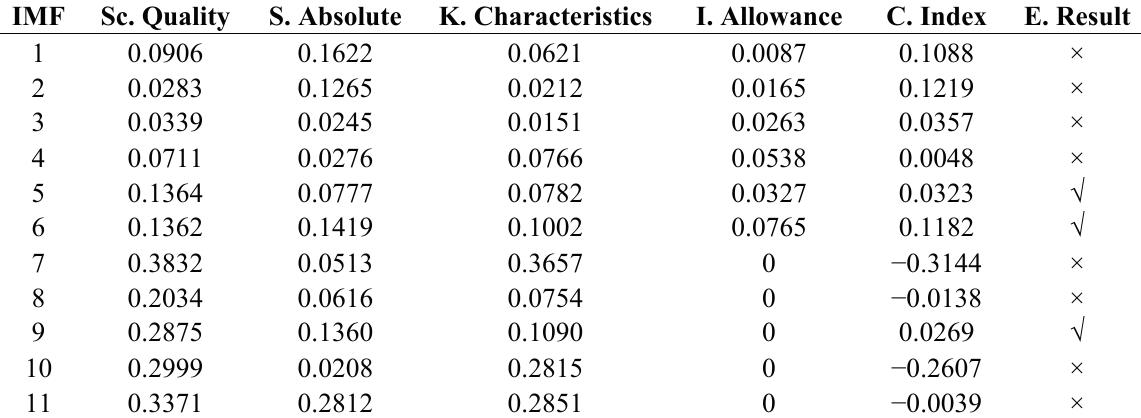
Figure 15. IMFs for the axle bearing vibration signal with a composite of three kinds of faults. Table 6. IMFs’ confidence index calculation for axle bearing vibration with a composite of three kinds of